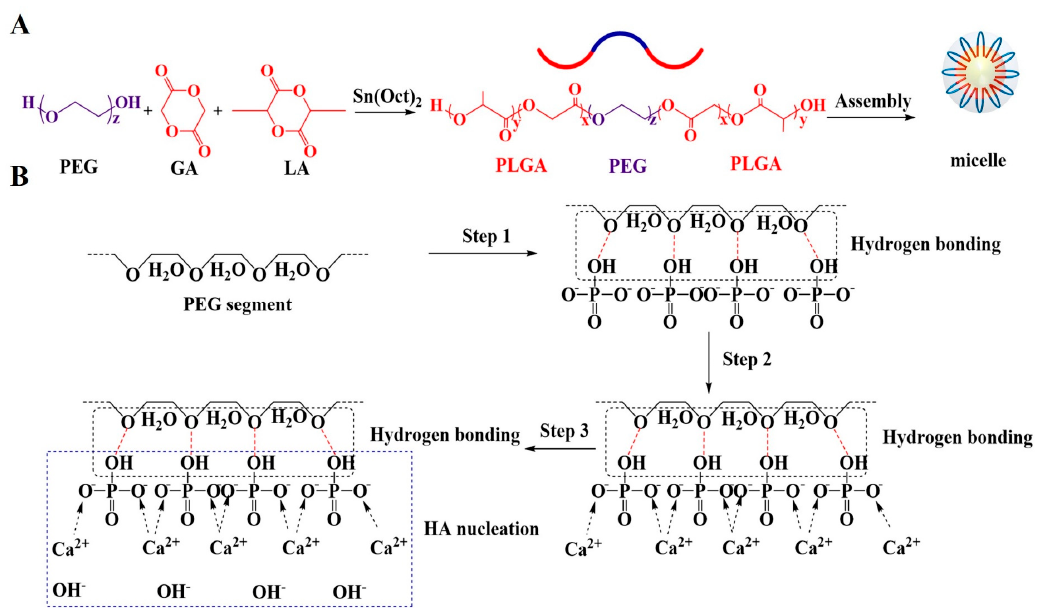
Figure 14. ( A ) The structure of PLGA-PEG-PLGA copolymer. ( B ) Schematic illustration showing the effect of PLGA-PEG-PLGA hydrogel on the hydration process of CPC.